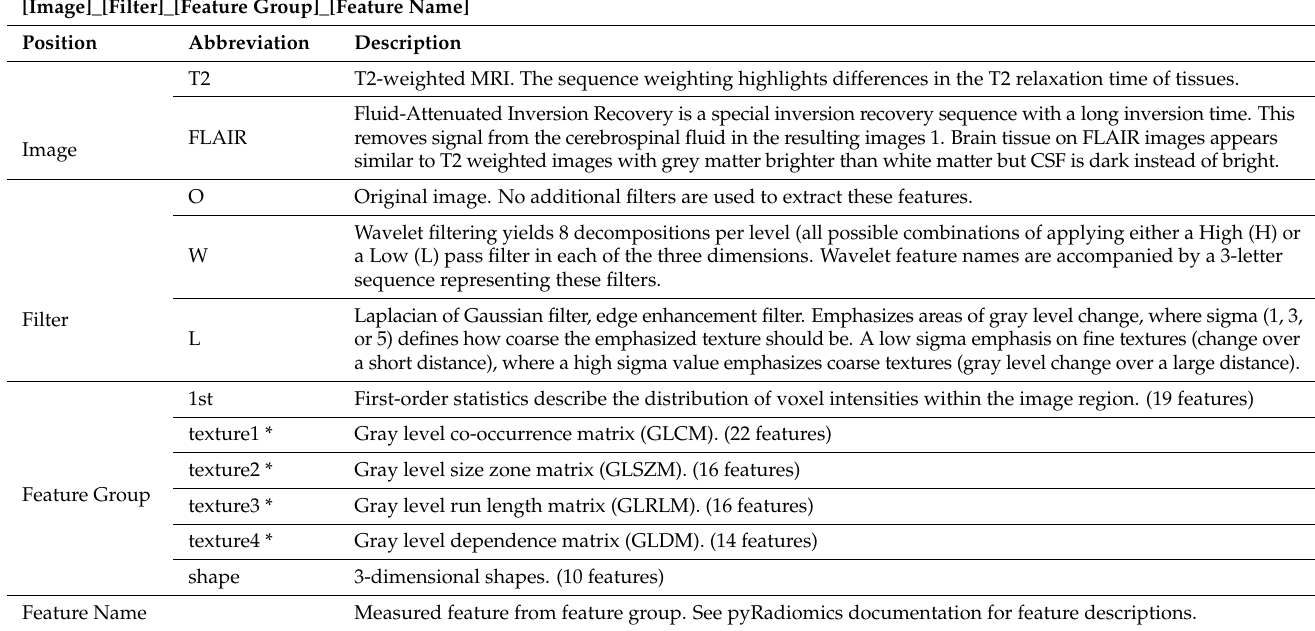
Table 1. Radiomic feature naming scheme and high-level